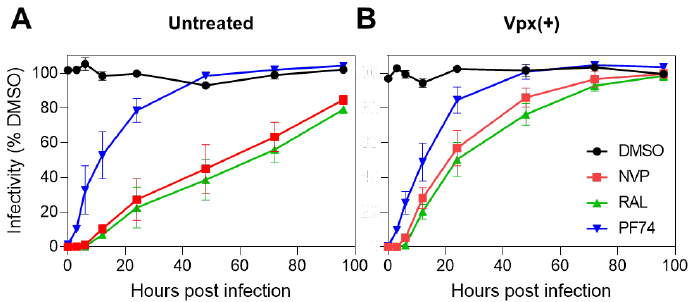
Figure 2. Time course of early steps of HIV-1 infection in monocyte-derived macrophages (MDMs) assessed by time of inhibitor addition. Untreated ( A ) and SIV-VLP Vpx( + )-treated MDMs ( B ) were infected with VSV-G-pseudotyped pNL4.3R-E-luc HIV-1 at an MOI of 2. Inhibitors of reverse transcription (nevirapine (NVP) 10 µM), capsid–host-factor interactions (PF74 2.5 µM), and integration (raltegravir (RAL) 20 µM) were added at indicated time points after synchronized infection (see Section 2). Results are normalized to DMSO control. Single round infectivity was measured at 5 days post-infection by luciferase assay. Error bars represent STD from triplicate experiments from 3